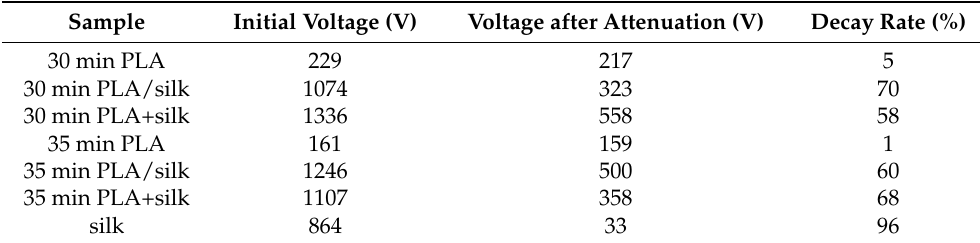
Table 5. The electrostatic attenuation data of samples.